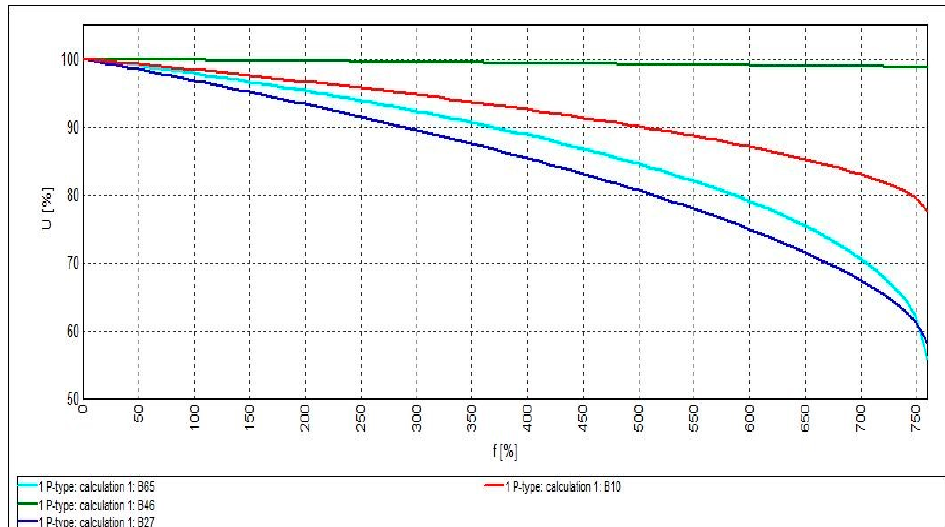
Figure 4. PV curves of the IEEE 69-node RDS system with 1 P-type DG installation.